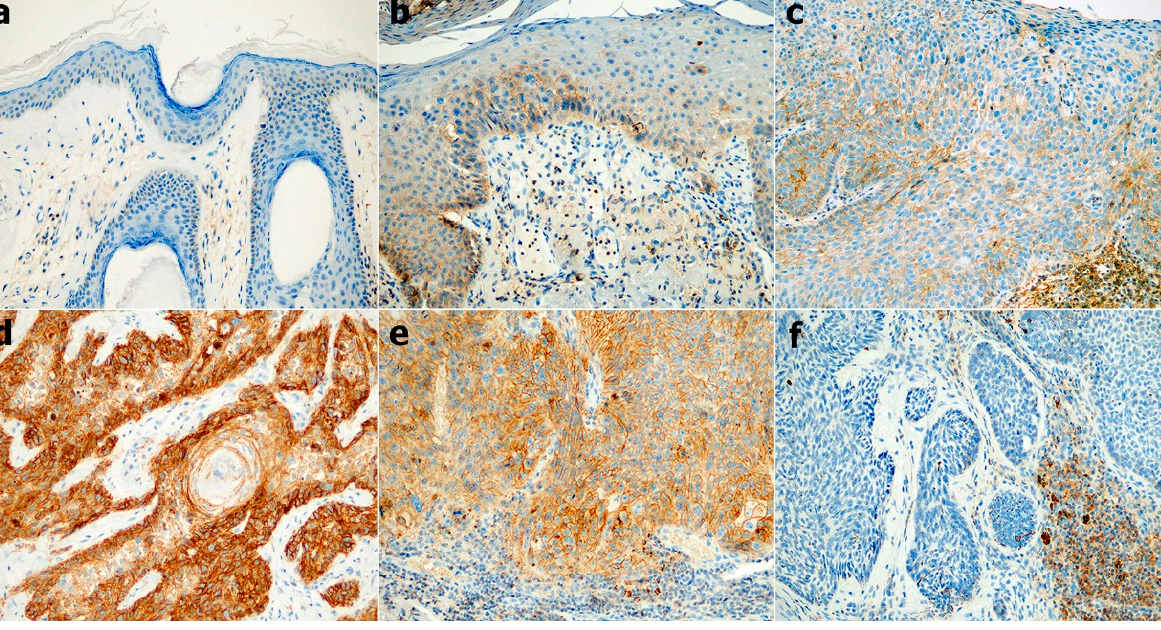
Figure 3. CD47 expression in normal skin ( a ), actinic keratosis ( b ), squamous cell carcinoma in situ ( c ), squamous cell carcinoma ( d ), keratoacanthoma ( e ), and basal cell carcinoma ( f ) ( a – f , x200).